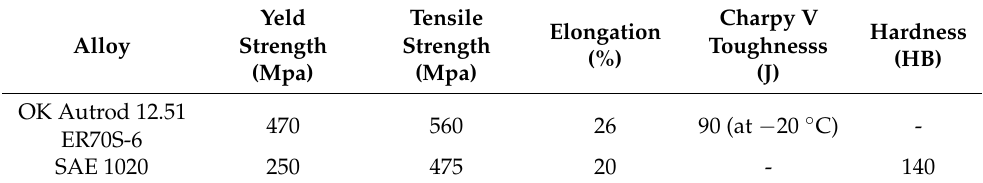
Table 2. Mechanical properties of wire and base metal